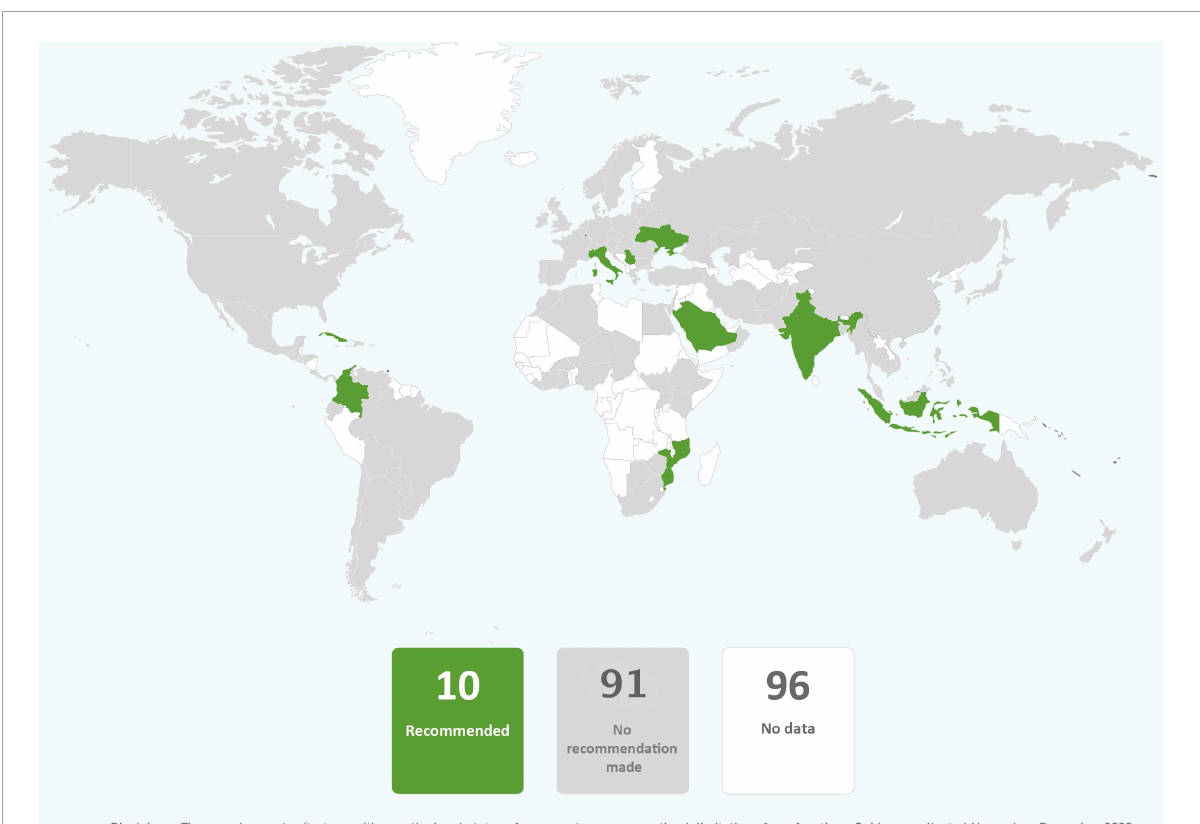
FIGURE6 Global distribution of recommendations on relactation support for mothers with COVID-19 (data from 101